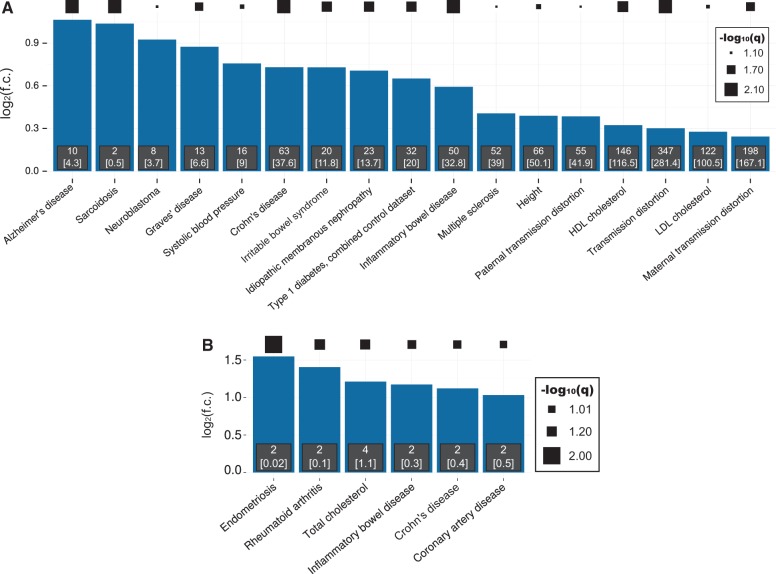
VDR-BVs are enriched in GWAS LD blocks for autoimmune, inflammatory and other diseases. (A,B) Traits and diseases showing enrichment of VDR-BVs (A) or VDR-rBVs (B). Diseases/trait associations were acquired from the GRASP catalog v2.0 (29). Statistical association was computed between VDR-BVs and strong-LD (Supplementary Material) intervals around genome-wide significant (P<5 × 10−8) disease tag-SNPs from the GRASP catalog. All available GRASP diseases and traits represented by at least 5 SNPs were analysed and those showing significant enrichment of VDR binding beyond a 1% FDR threshold were retained; disease associations supported by only 1 VDR-BV were discarded (full data are presented in the Supplementary Material). The sizes of black squares indicate the statistical significance of enrichments.